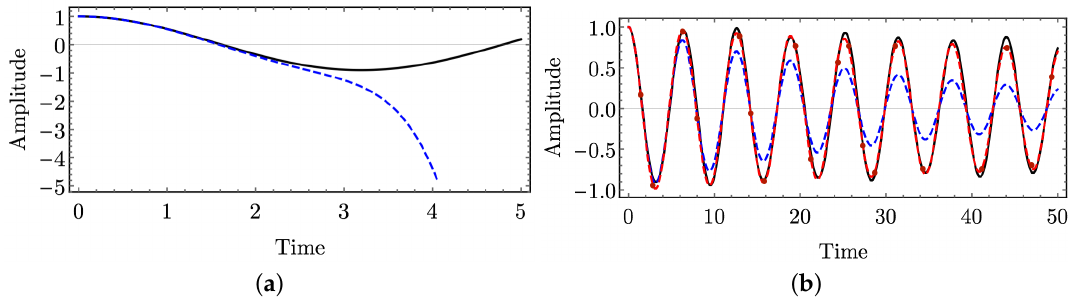
Figure 6. Example 3. ( a ) The black curve is the numerical solution and the dashed blue curve is the solution by the DTM given by Equation (29); ( b ) The dashed blue curve is the solution by the MDTM and Padé [3/3] approximant solution. The dashed red curve is the solution by the MDTM and Padé [4/4] approximant. The black curve is the numerical